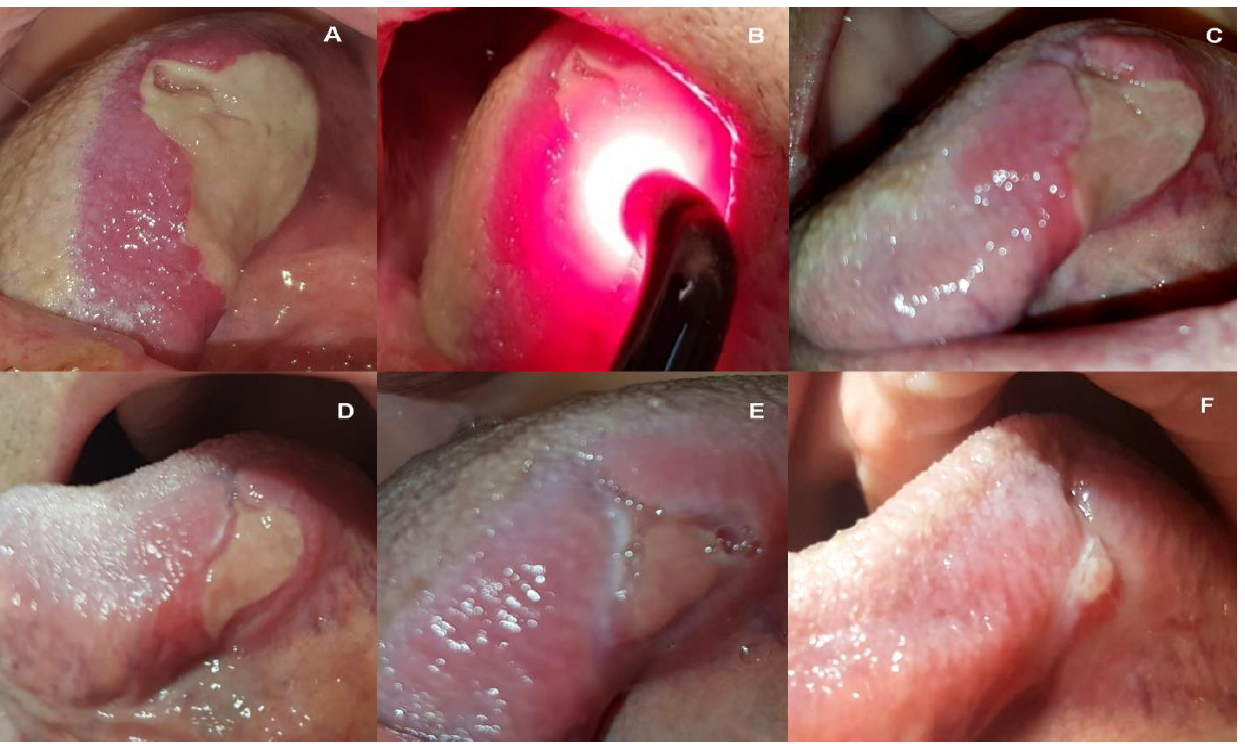
Figure 1. Images of the extensive ulceration on the left lateral surface of the tongue, just before the 1st PBM procedure ( A ), during the 1st PBM ( B ), on the 4th day after the 1st irradiation, and before the 2nd PBM ( C ), on the 7th day before the 3rd PBM treatment ( D ), on the 14th day after the first treatment before the 5th PBM ( E ), and on the 21st day before the 7th and last PBM treatment ( F ).